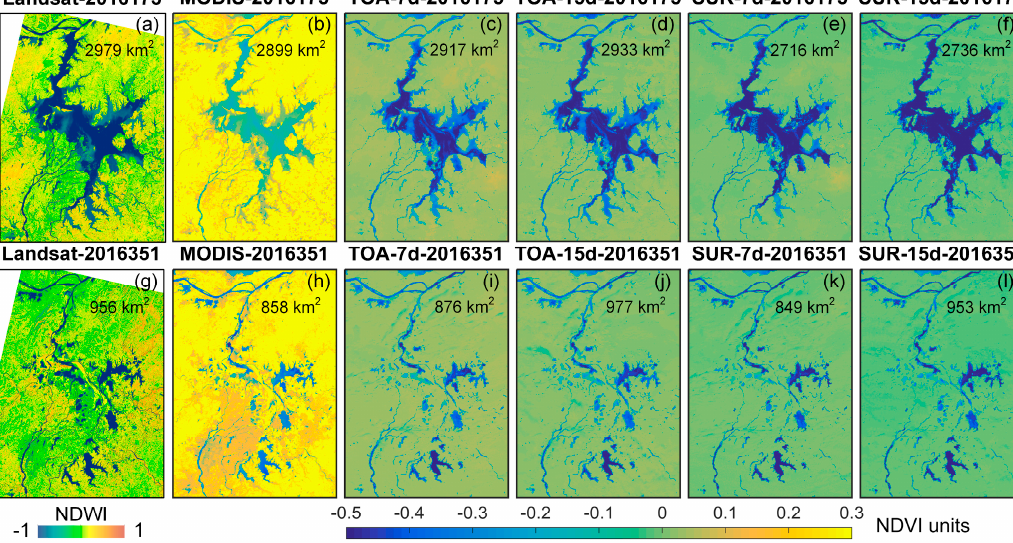
Figure 4. Comparison of concurrent Landsat Normalized Di ff erence Water Index (NDWI) ( a , g ), cloud free MODerate-resolution Imaging Spectroradiometer (MODIS) NDVI ( b , h ), MinVC NDVI based on 7-day TOA reflectance data ( c , i ), MinVC NDVI based on 15-day TOA reflectance data ( d , j ), MinVC NDVI based on 7-day surface reflectance data ( e , k ), and MinVC NDVI based on 15-day surface reflectance data ( f , l ). The upper row shows data in the wet season (DOY175, 2016), and the lower row shows data in the dry season (DOY351, 2016). The corresponding water surface area data are added.